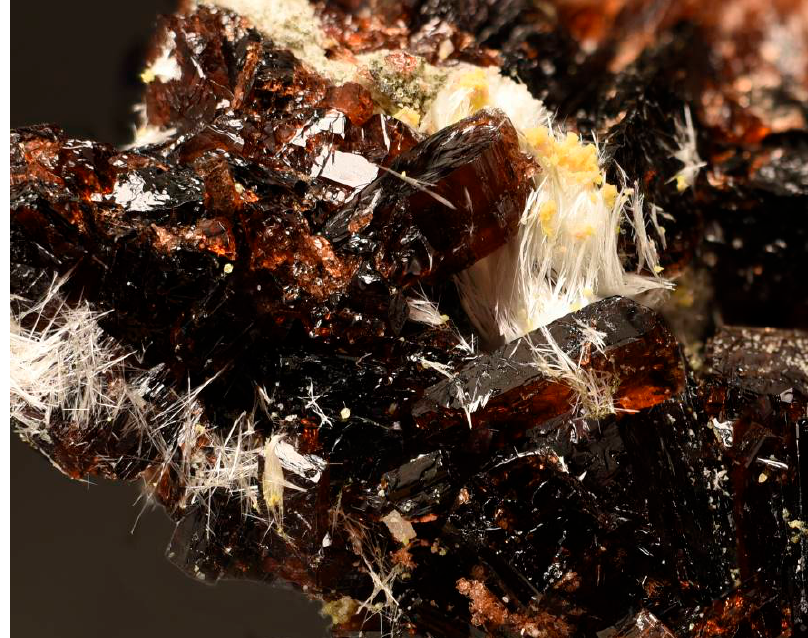
Figure 21. Römerite, prismatic crystals up to 1 cm with acicular crystals of halotrichite from the Monte Arsiccio mine.